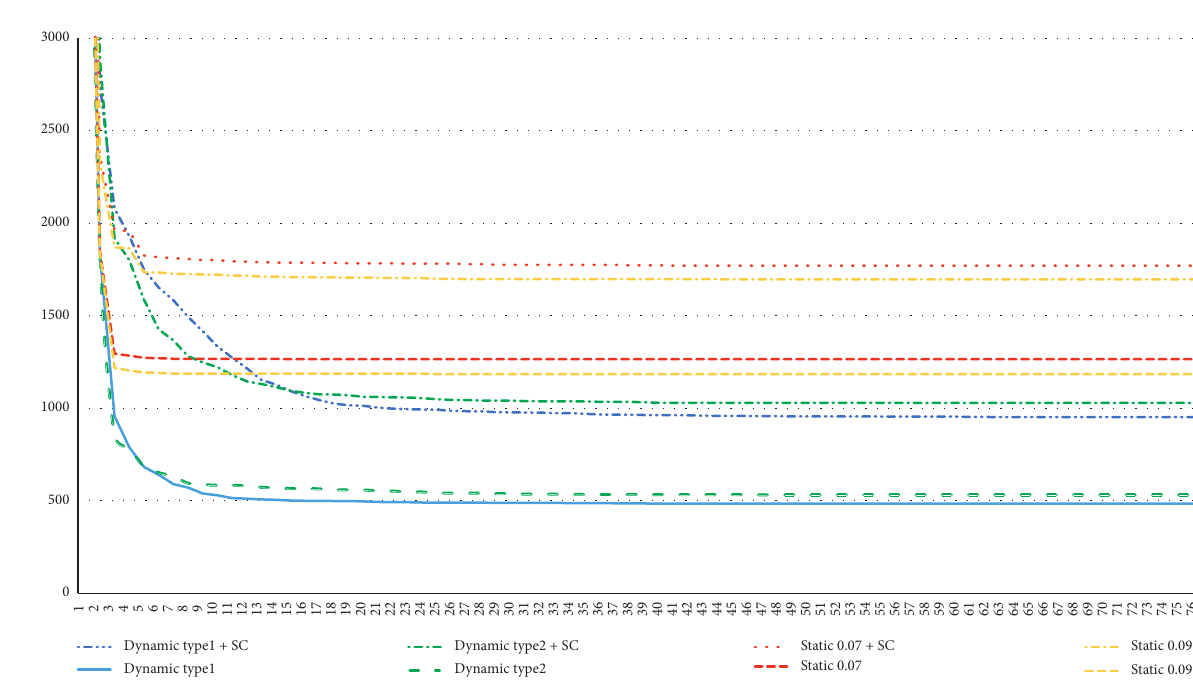
Figure 8: Rate of convergence for different step size with or without Security Control gates. Table 5: Convergence time analysis for the dynamic type 1.